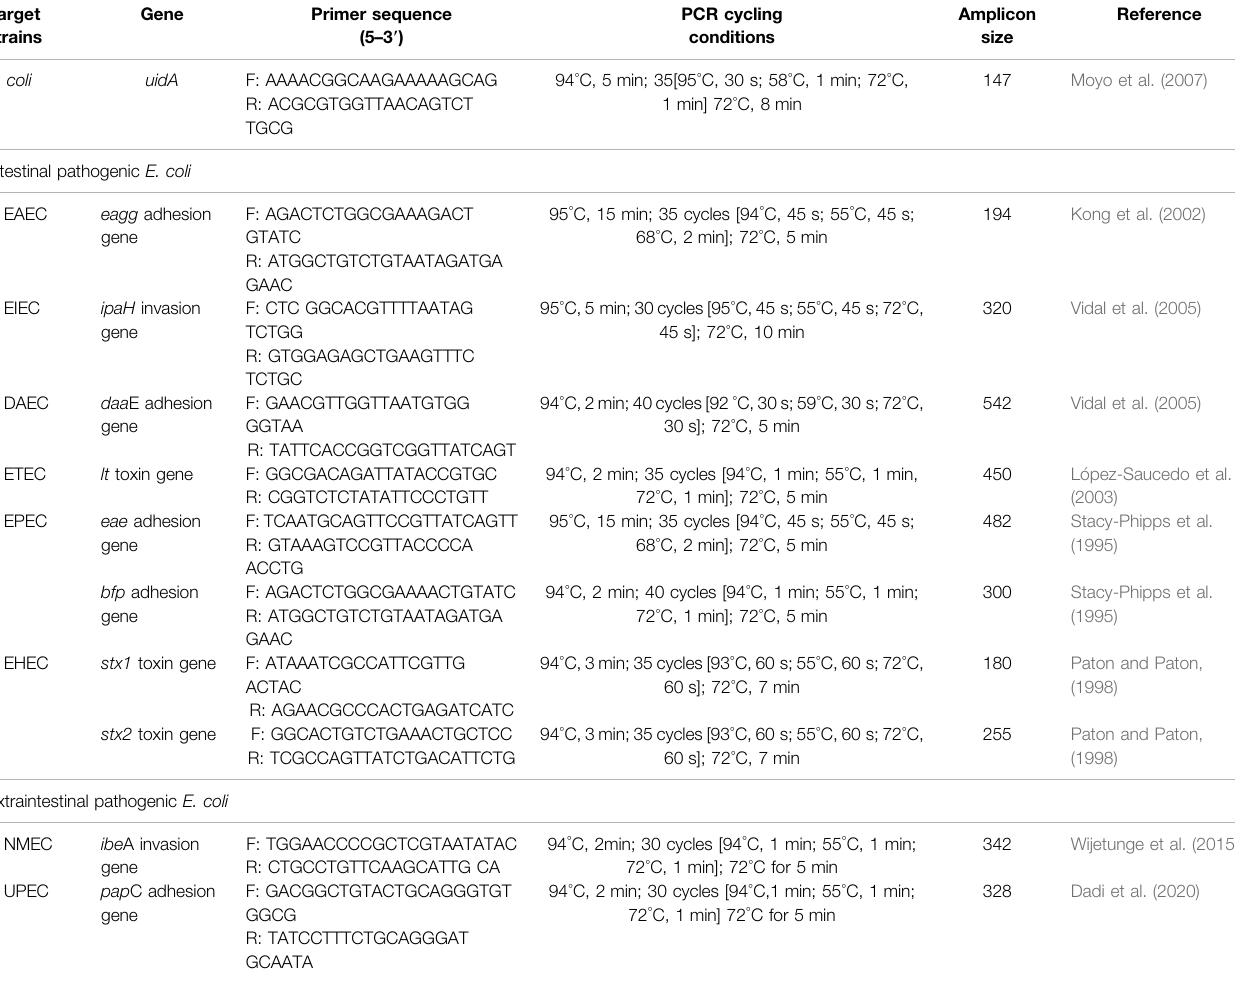
TABLE 1 | Primer sequence, PCR cycling conditions and expected amplicon sizes for the con fi rmation and delineation of E. coli into its pathotypes. Target